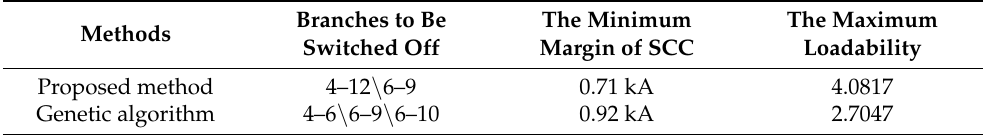
Table 1. Comparative results between the proposed method and genetic algorithm.